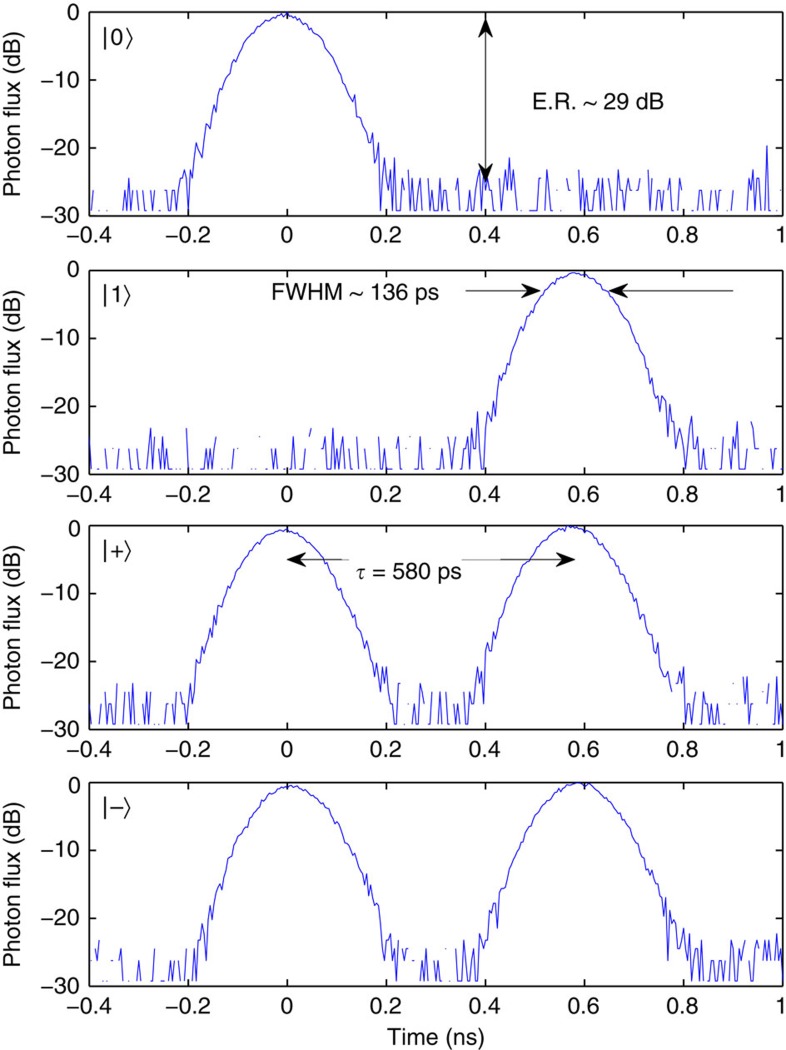
Transmitter output for the BB84 states.Single photon histogram measurements demonstrating the 136 ps full-width-half-maximum (FWHM) pulses with near 30 dB extinction. The two time-bins have a temporal separation of 580 ps, with a 0 or π relative phase difference for the |+> and |−> states, respectively.